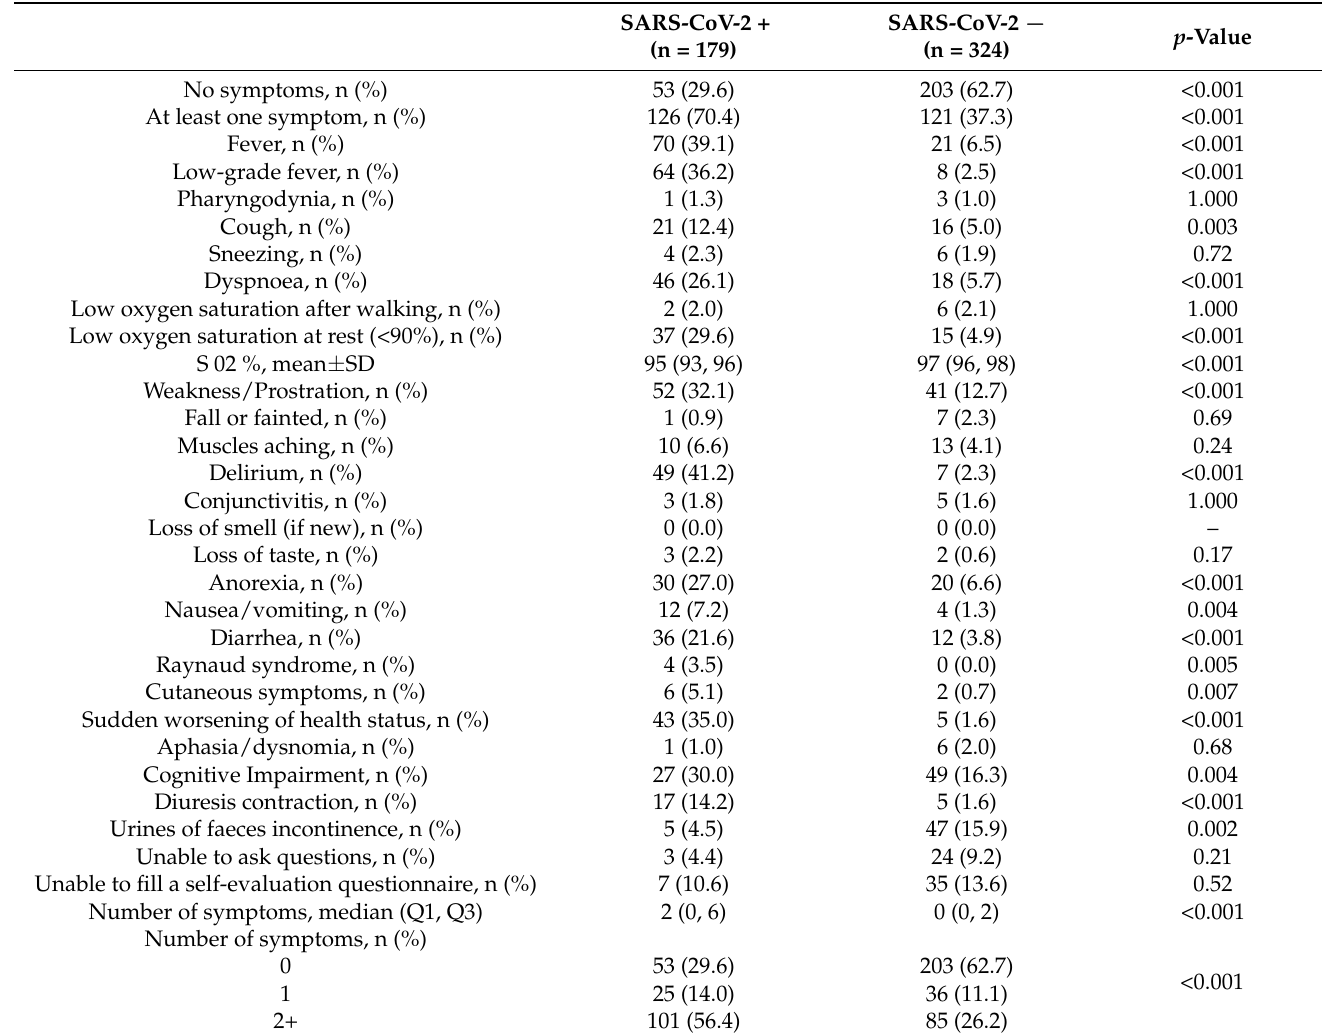
Table 2. Symptoms of older adults from the GeroCovid LTCFs study, according to SARS-CoV-2 infec- tion